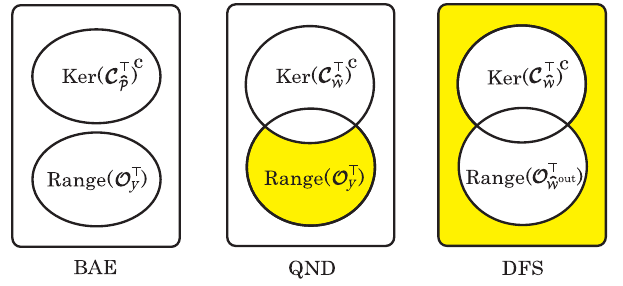
FIG. 2. Systematic characterizations of BAE, QND, and DFS, represented by the set of vectors v ∈ R 2 n , where the correspond- ing quantum variables are given by v ⊤ ˆ x . Ker ð C ⊤ (cid:129) Þ c and Range ð O ⊤ (cid:129) Þ denote the controllable and observable subspaces, respectively. The colored region represents the set of QND variables (middle) and the set of variables in a DFS (right).